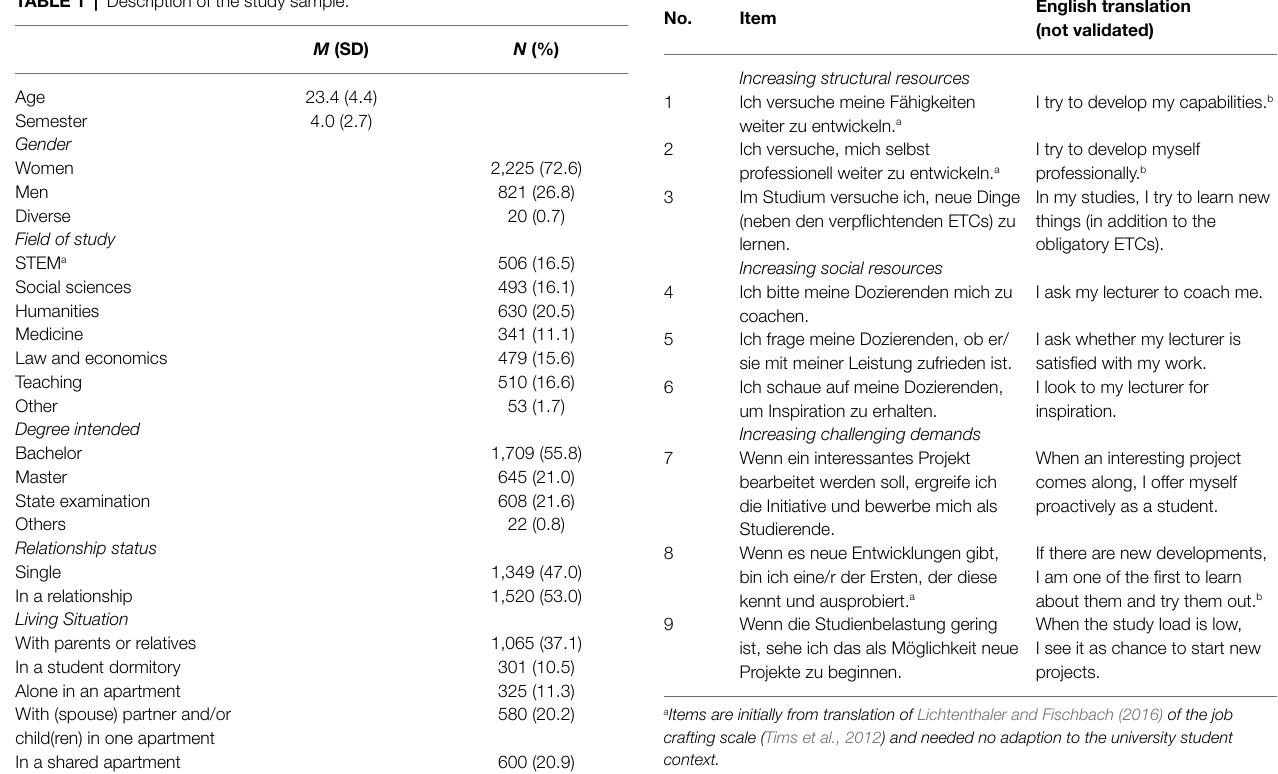
TABLE 1 | Description of the study